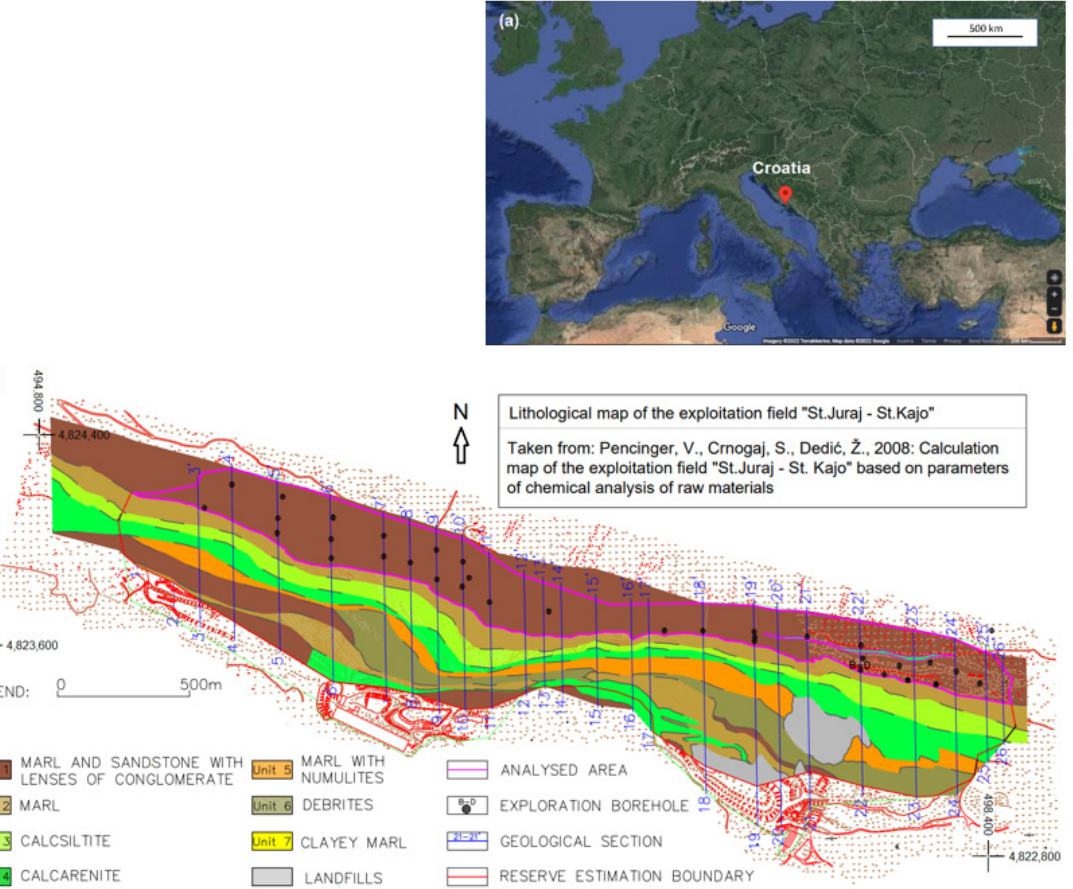
Figure 1. ( a ) Geographical location [24] and ( b ) lithological map of the exploitation field “St. Juraj–St. Kajo” (after [23,25]).